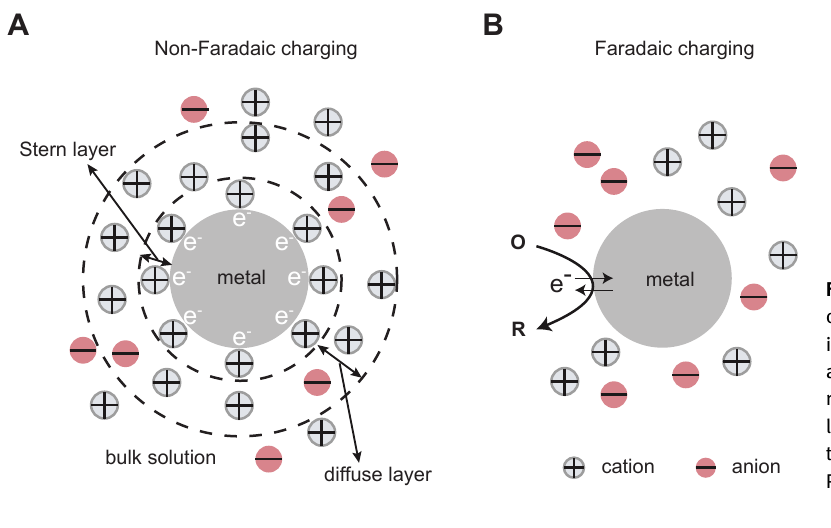
Figure8: Faradaicandnon-Faradaiccharging of PNAs: (A) Non-Faradaic charging results inredistributionoffree-carrierchargesinan atomic-scale electrical double layer sur- rounding the PNA; (B) Faradaic charging leads to injection or extraction of electrons through redox electrochemical